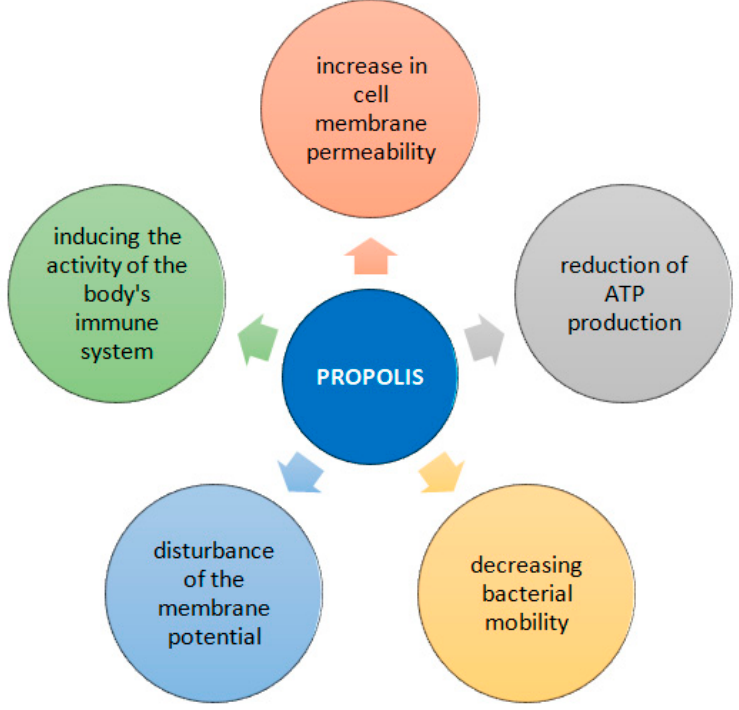
Figure 5. The mechanisms of propolis activity against bacteria.